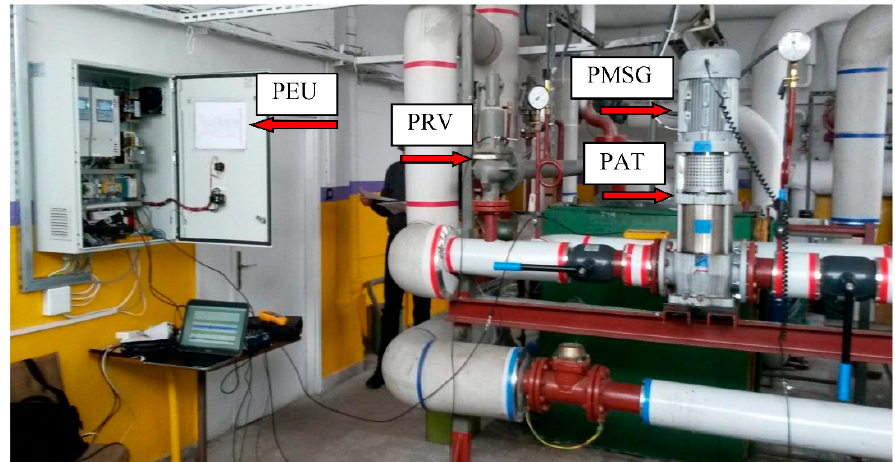
Figure 8. ERPR prototype installed in the substation of the Cracow DHS.